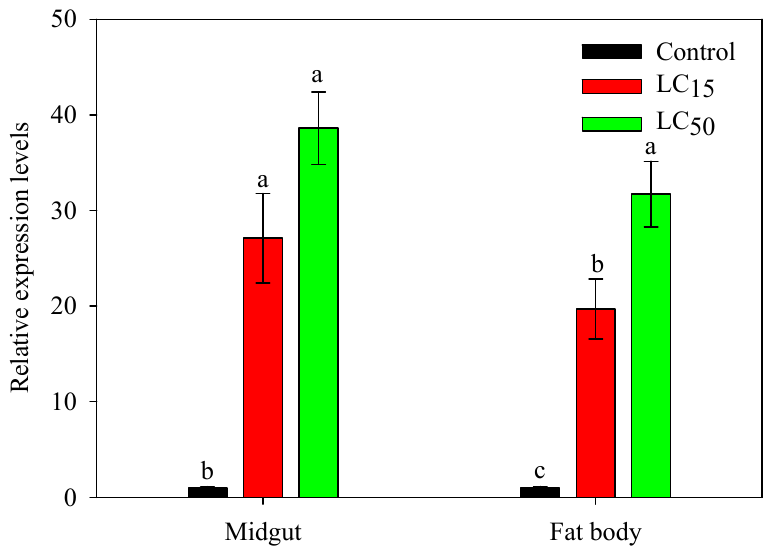
Figure 4. Effects of phoxim on SlCPR expression in the midgut and fat body of fifth-instar larvae. Larvae were exposed to phoxim at LC 15 (4 μ g/mL) and LC 50 (20 μ g/mL) doses for 24 h. SlCPR expression levels were normalized to β -actin and EF1 expression and presented as the means ± SE with three independent biological replicates and three technical replicates. Different letters (a,b,c) above bars indicate significant differences ( p < 0.05) according to Duncan’s multiple range test.